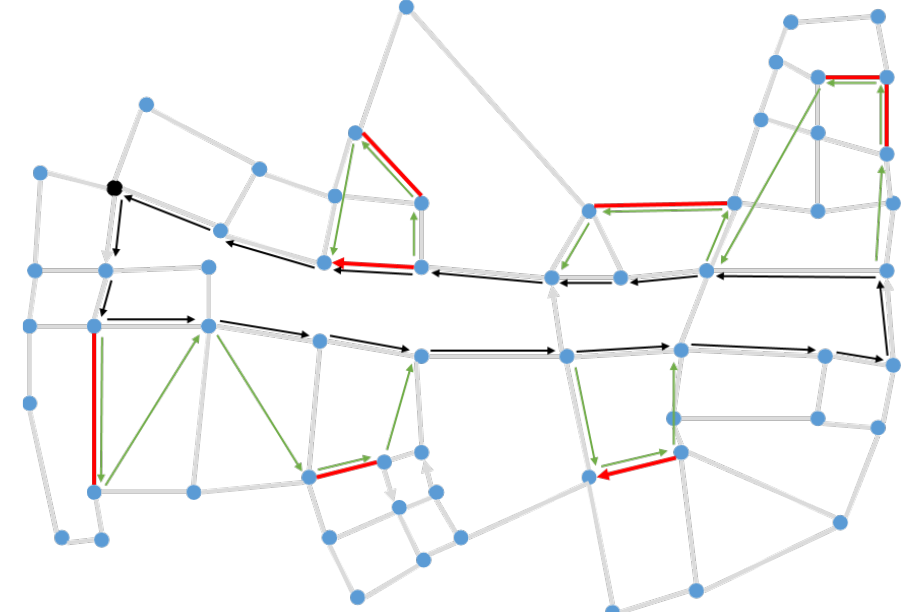
Figure 14. Route planning of the truck and the drones.